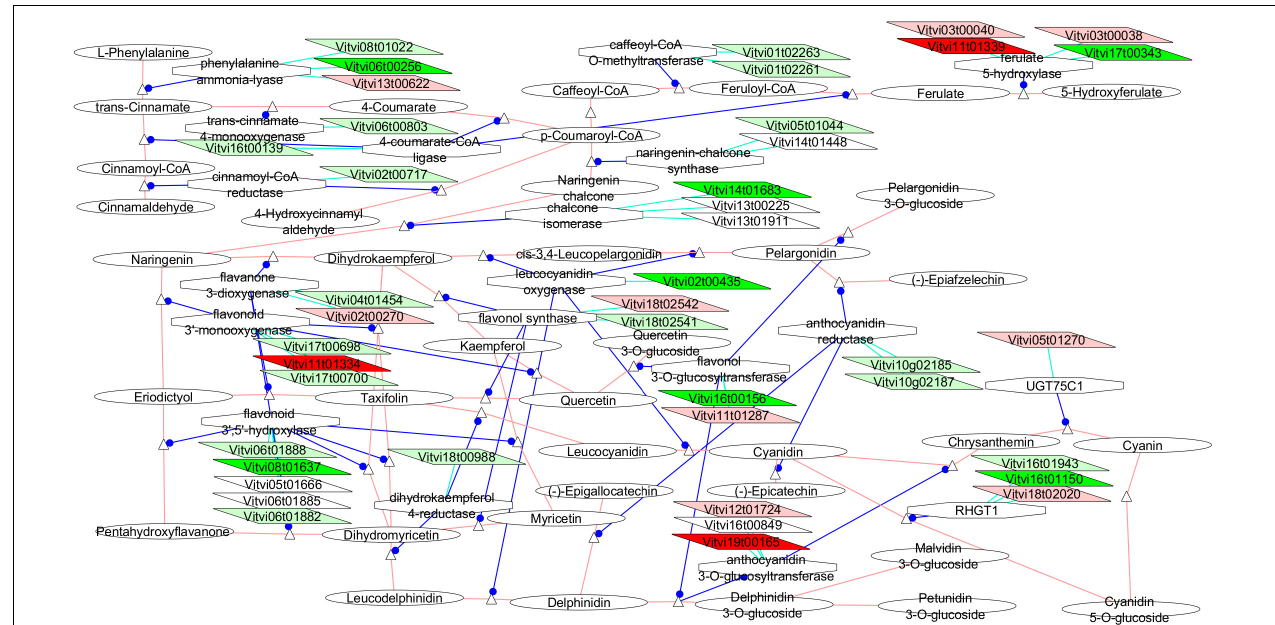
FIGURE 7 | Adapted Cytoscape VitisNet networks including transcripts differentially expressed in flowers at E-L 18 – 19 between VP11 and the compact clones related to polyphenols metabolism. Dark red, genes over-expressed in compact clones RJ51 and VP2; light red, genes over-expressed in compact clone RJ51 vs. VP11; dark green, genes over-expressed in loose clone VP11 vs. both compact clones; light green, genes over-expressed in loose clone VP11 vs. RJ51. Figure was adapted from networks 10940 (phenylpropanoids), 10941 (flavonoids), and 10942 (anthocyanins) from Grimplet et al. (2009), genes in white were over-expressed in another studied condition; the transcripts not differentially expressed were removed from the